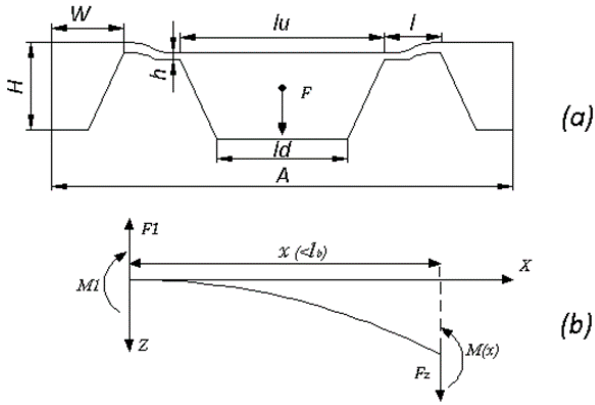
Figure 4. ( a ) Diagrammatic sketch of the chip structure; ( b ) Schematic of applied force and torque balance in the suspending